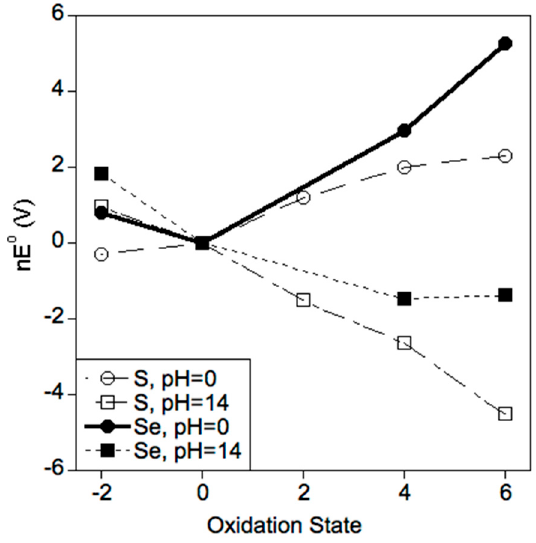
Figure 1. Frost diagrams for sulfur and selenium at pH 0 and 14. The nE° = 0 value is arbitrarily assigned to the zero-valent state. Note that S( − II) and Se(0) are the most stable oxidation states at pH 0, and that S(VI) and Se(VI) are the most stable at pH 14.